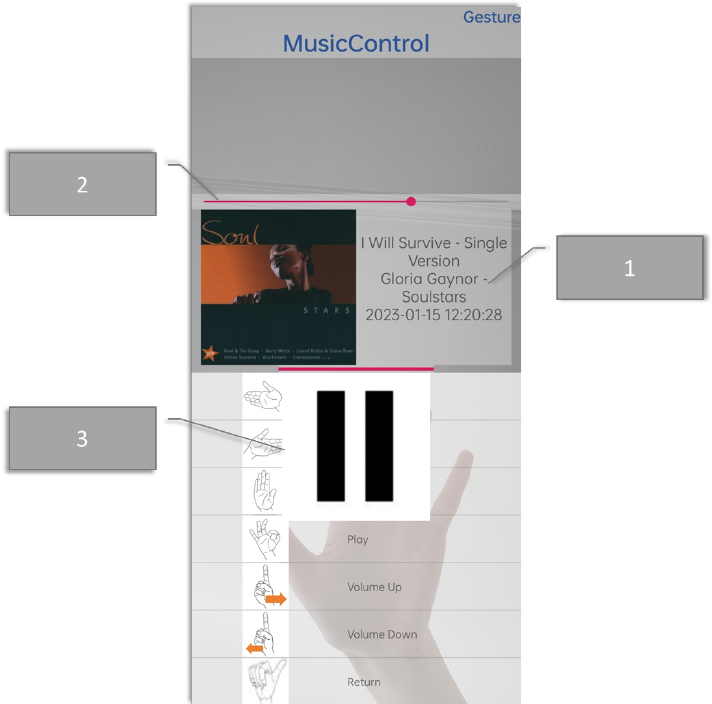
Figure 7. Music control interface. No. 1 indicates the detailed information and cover of the music being played. No. 2 represents the volume display. No. 3 indicates the pop-up window when the operation is completed. Currently displayed is the pop-up window for the completion of the Music Pause